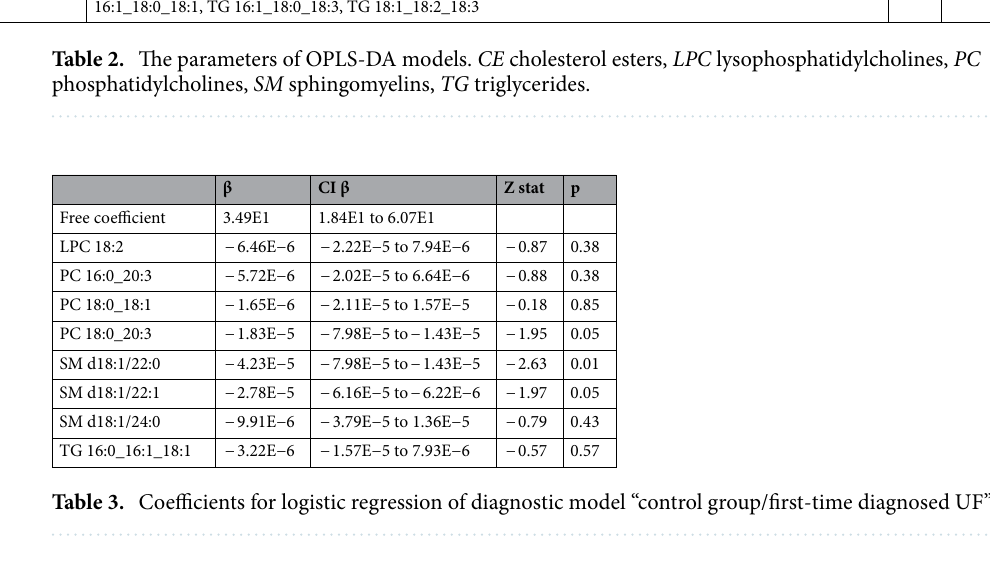
β CI β Z stat Free